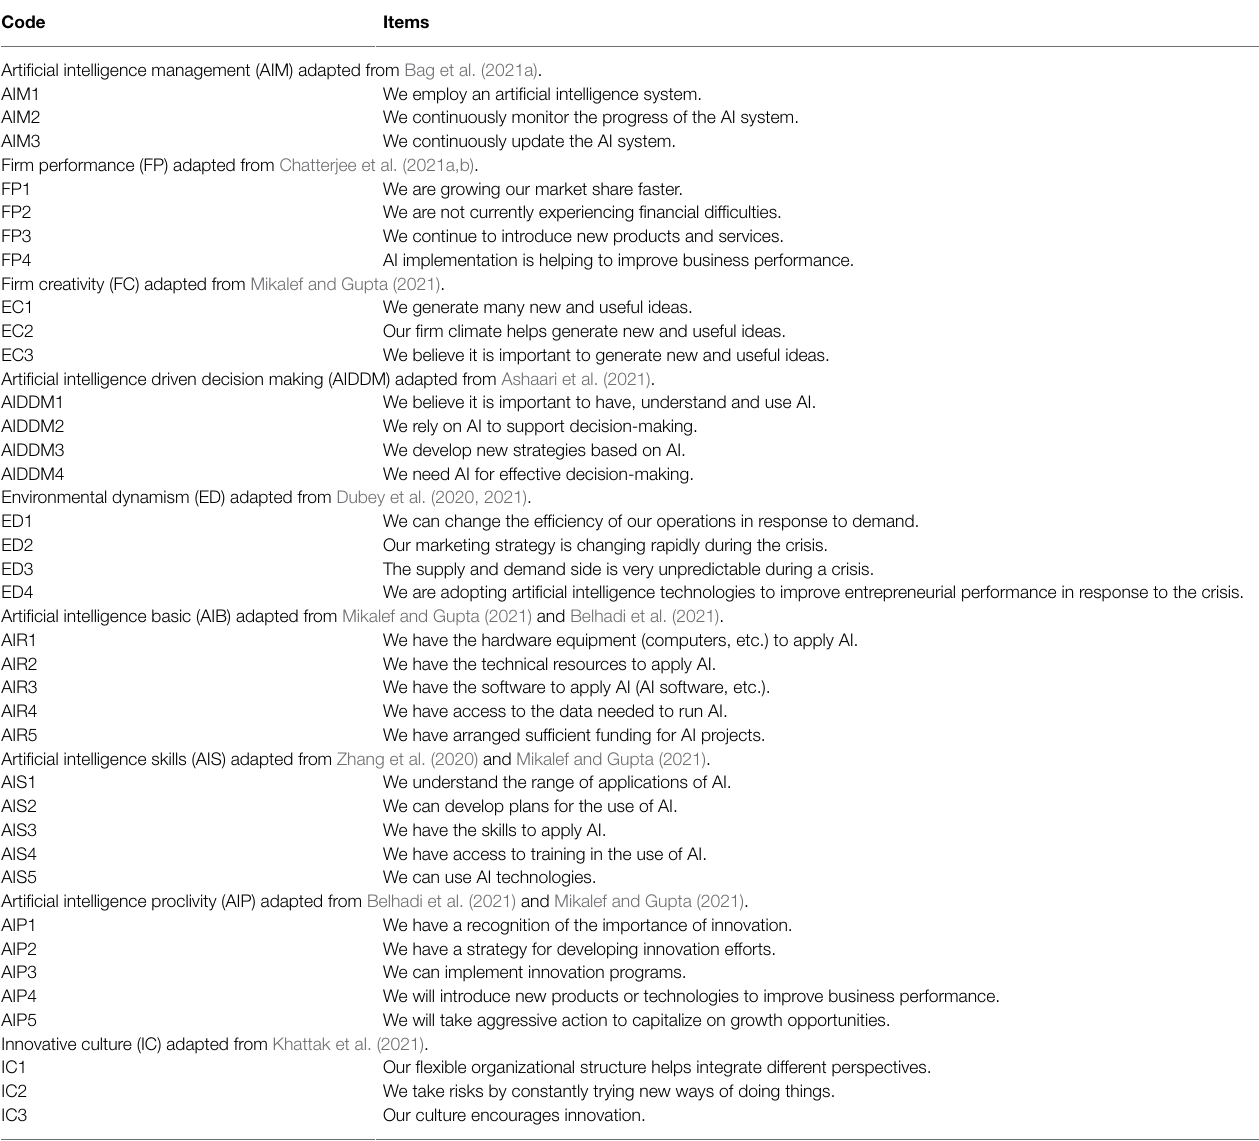
TABLE 1 | Measurement scale. Code